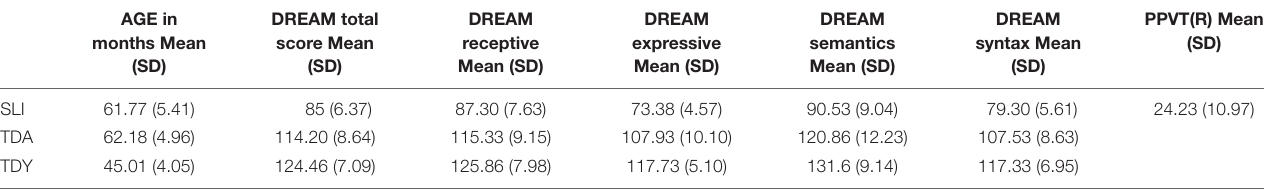
TABLE 2 | Detailed profiles of the three groups of